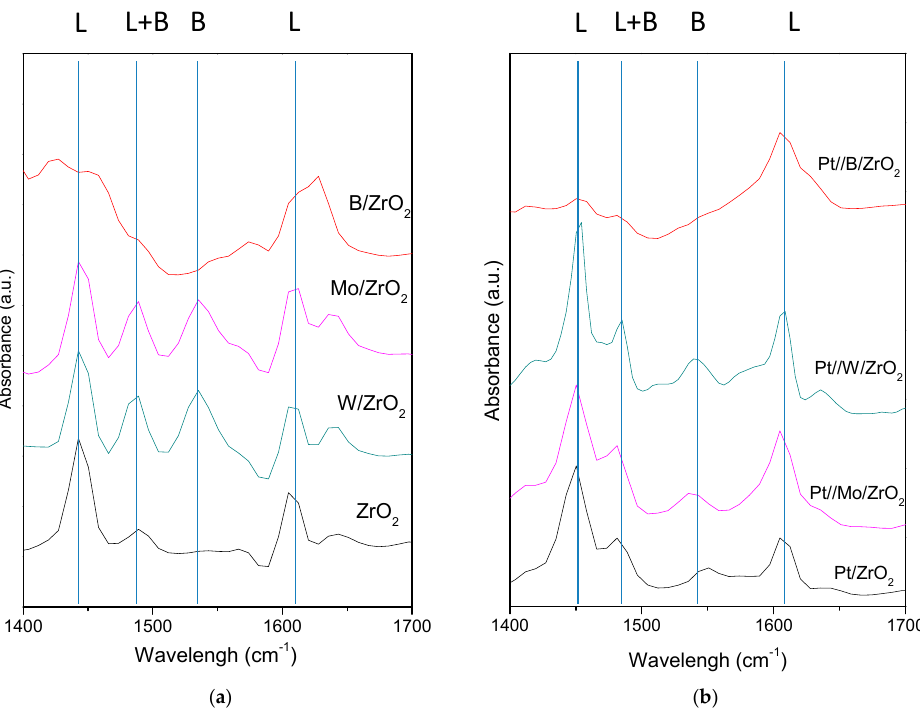
Figure 3. Diffuse reflection infrared spectroscopy of chemisorbed pyridine (Py-DRIFT) patterns obtained for supports ( a ) and supported Pt catalyst ( b ). Spectra were taken after pyridine adsorption and subsequent heating to 200 °C for 60 min.